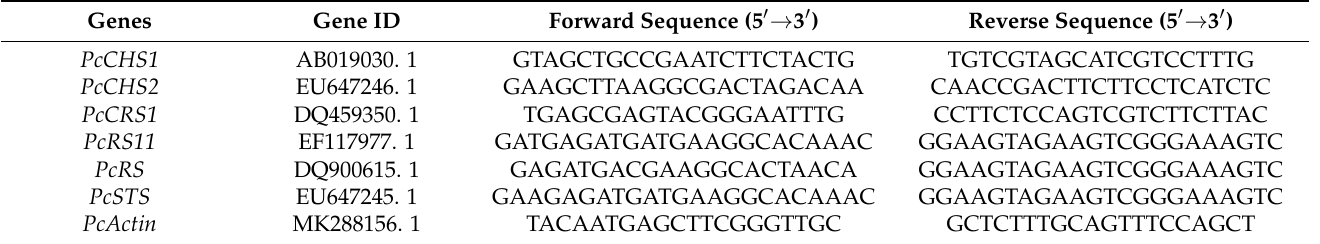
Table 1. Primer sequences of associated genes in resveratrol